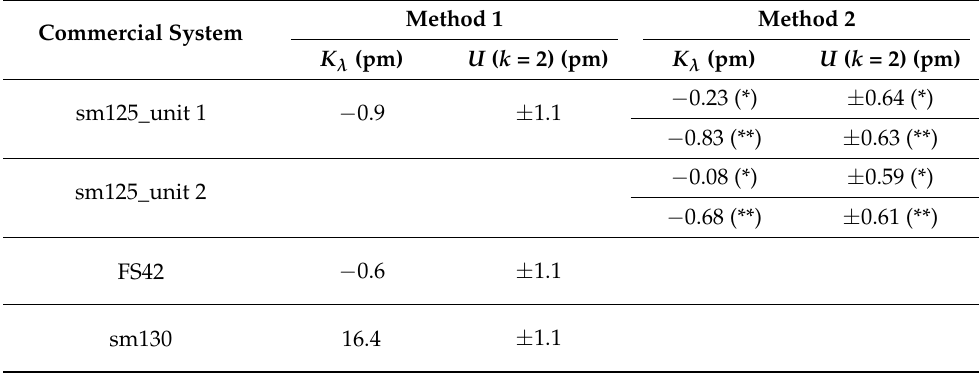
Table 5. Mean correction constants and expanded uncertainties ( k = 2) for the four commercial systems